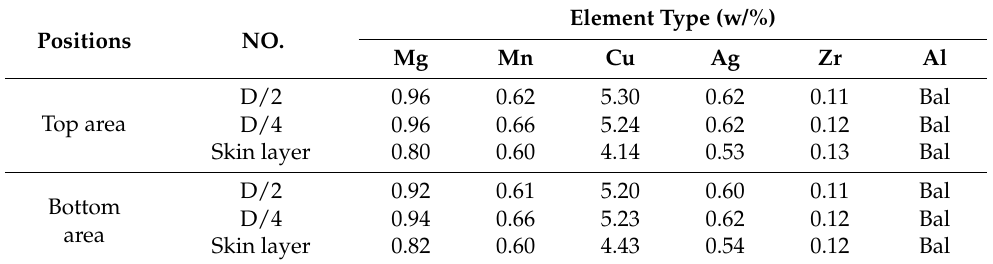
Table 1. Results of the chemical composition analysis of the different typical positions in the ingot.